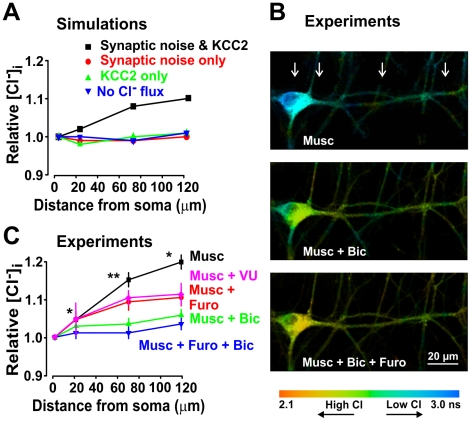
A standing somato-dendritic Cl− gradient is caused by the joint action of KCC2 activity and GABAAR mediated synaptic input.
A. Distribution of [Cl−]i in a modeled dendrite as a function of distance from the soma in the presence and absence of Cl− load due to distributed synaptic activity and of Cl− extrusion through uniformly distributed KCC2. B. Photomicrographs of an example cell loaded with MQAE with lifetime color coding (blue: low Cl− concentration, red: high Cl− concentration). Intracellular Cl− concentration was measured in the presence of muscimol (Musc; 100 µM) and/or bicuculline (Bic; 100 µM) and/or furosemide (Furo; 200 µM) and/or VU 0240551 (VU, 15 µM). Arrows indicate the location where measurements were performed. C. Effect of tonic activation of GABAARs by muscimol on [Cl−]i in real dendrites as a function of distance from the soma (each data point represent mean ± SEM taken from 10–12 neurons; values from several dendrites were averaged for each cell). Bicuculline and/or furosemide and/or VU 0240551 were added to block Cl− loading and extrusion, respectively.